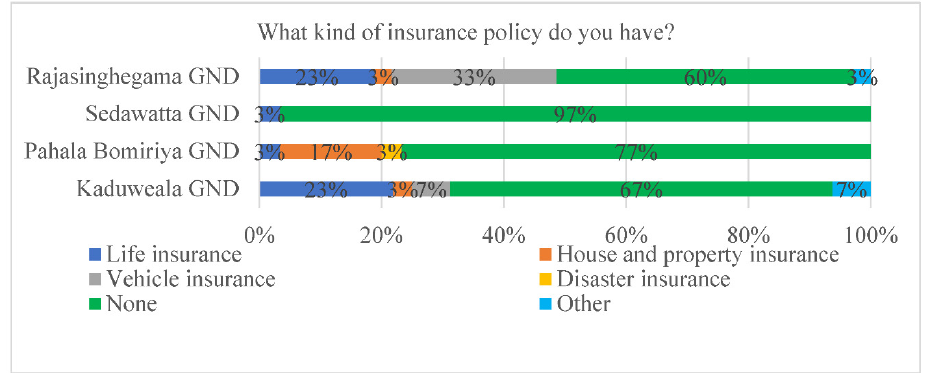
Figure 4. Types of insurance policy communities had.